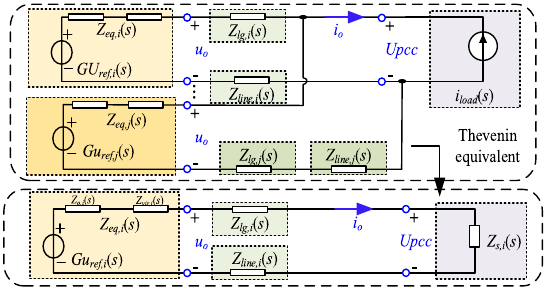
Fig. 11 Stability constraints with R vh and L vh variations